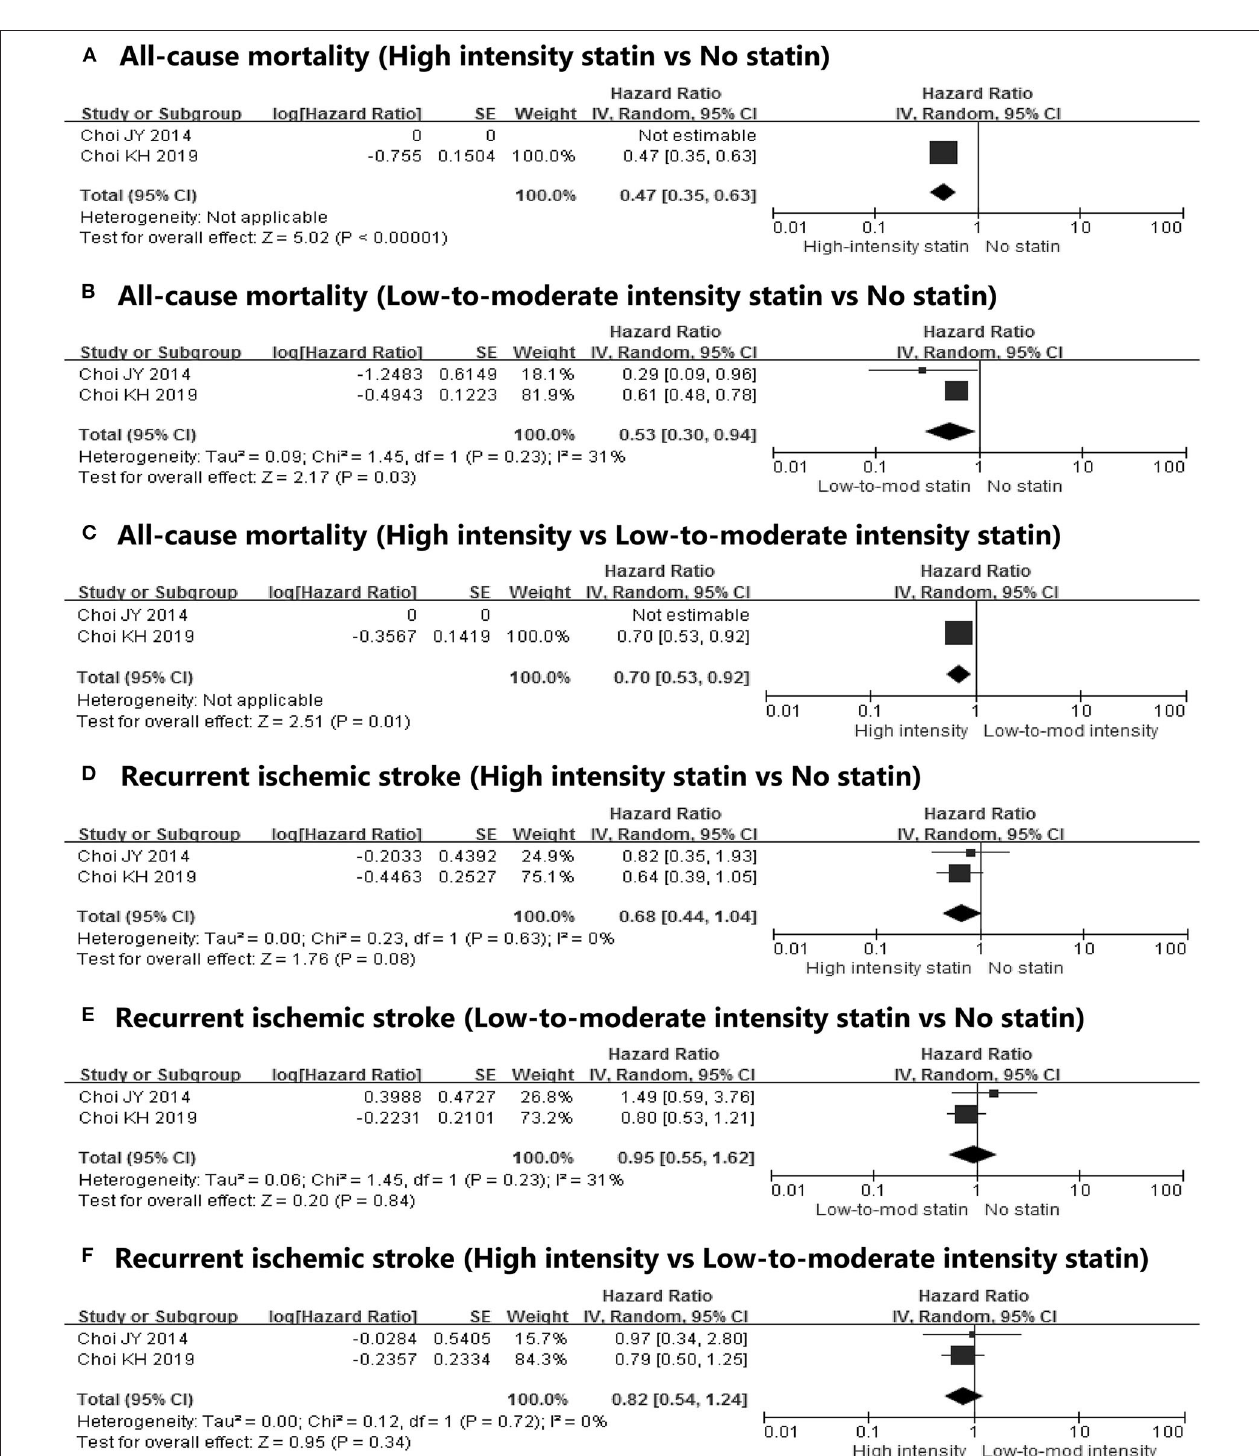
FIGURE 3 | Subgroup meta-analyses on the effect of post-statin therapy on (A) all-cause mortality (high-intensity statin vs. no statin), (B) all-cause mortality (low-to-intermediate-intensity statin vs. no statin), (C) all-cause mortality (high-intensity vs. low-to-moderate intensity statin), (D) recurrent ischemic stroke (high-intensity statin vs. no statin), (E) recurrent ischemic stroke (low-to-intermediate-intensity statin vs. no statin), and (F) recurrent ischemic stroke (high-intensity vs. low-to-moderate-intensity statin) stratified by the intensity of statins.